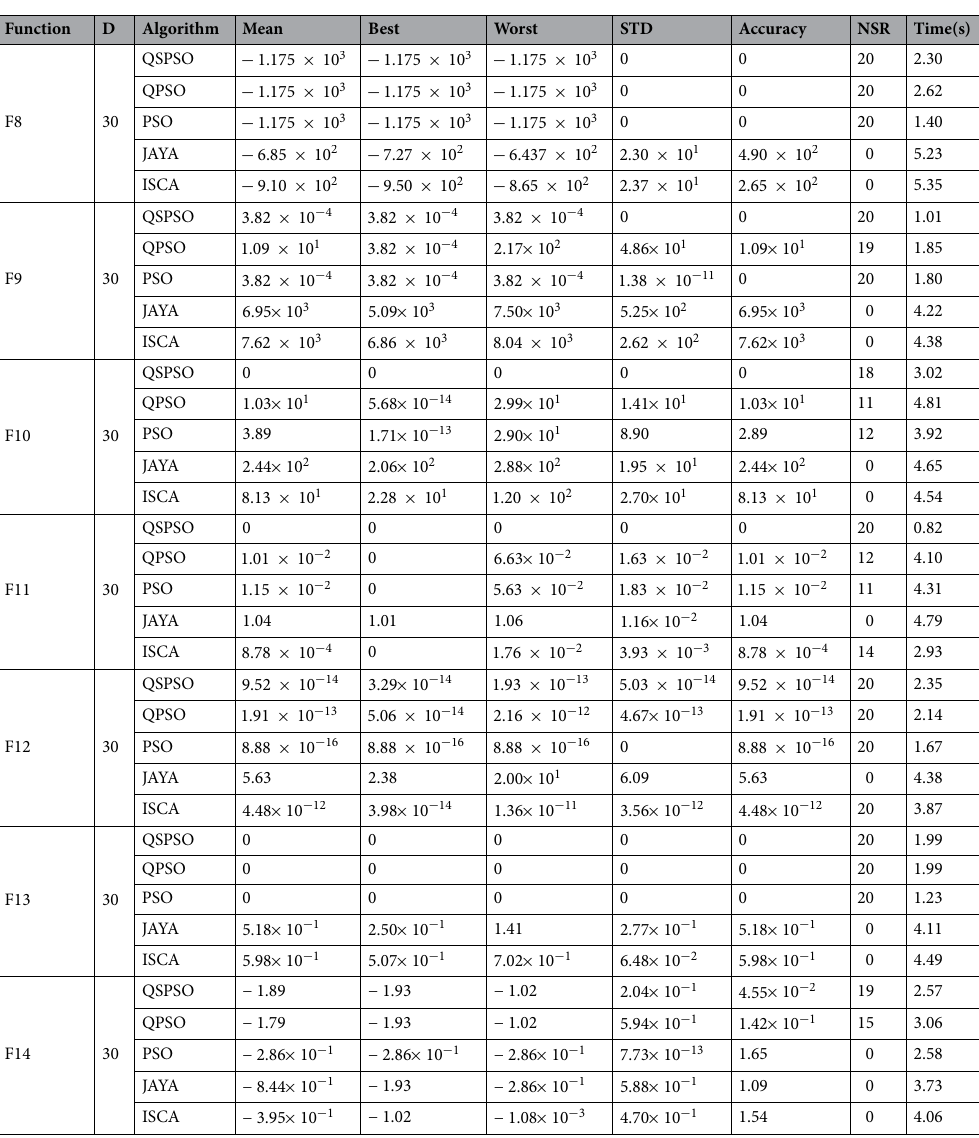
Table 3. Numerical results for multimodal benchmark